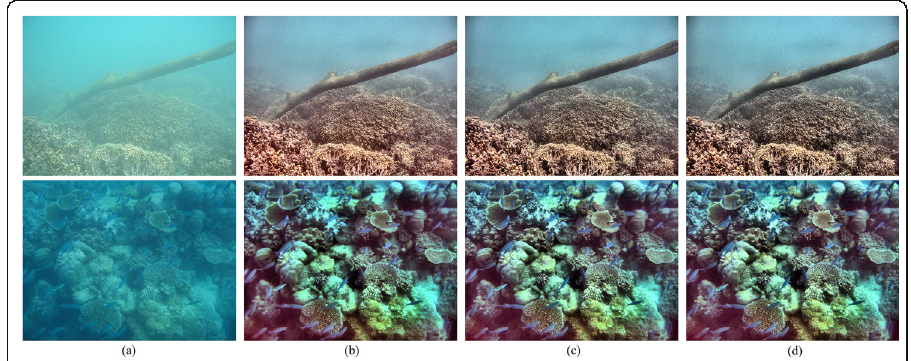
Fig. 3 Analysis of the local patch size. a Input image. b Recovered image with patch size 3 × 3. c Recovered image with patch size 15 × 15. d Recovered image with patch size 21 × 21